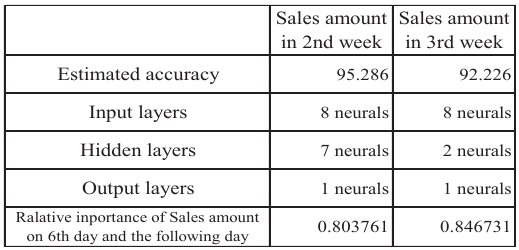
Table 3. Result of the learning process.